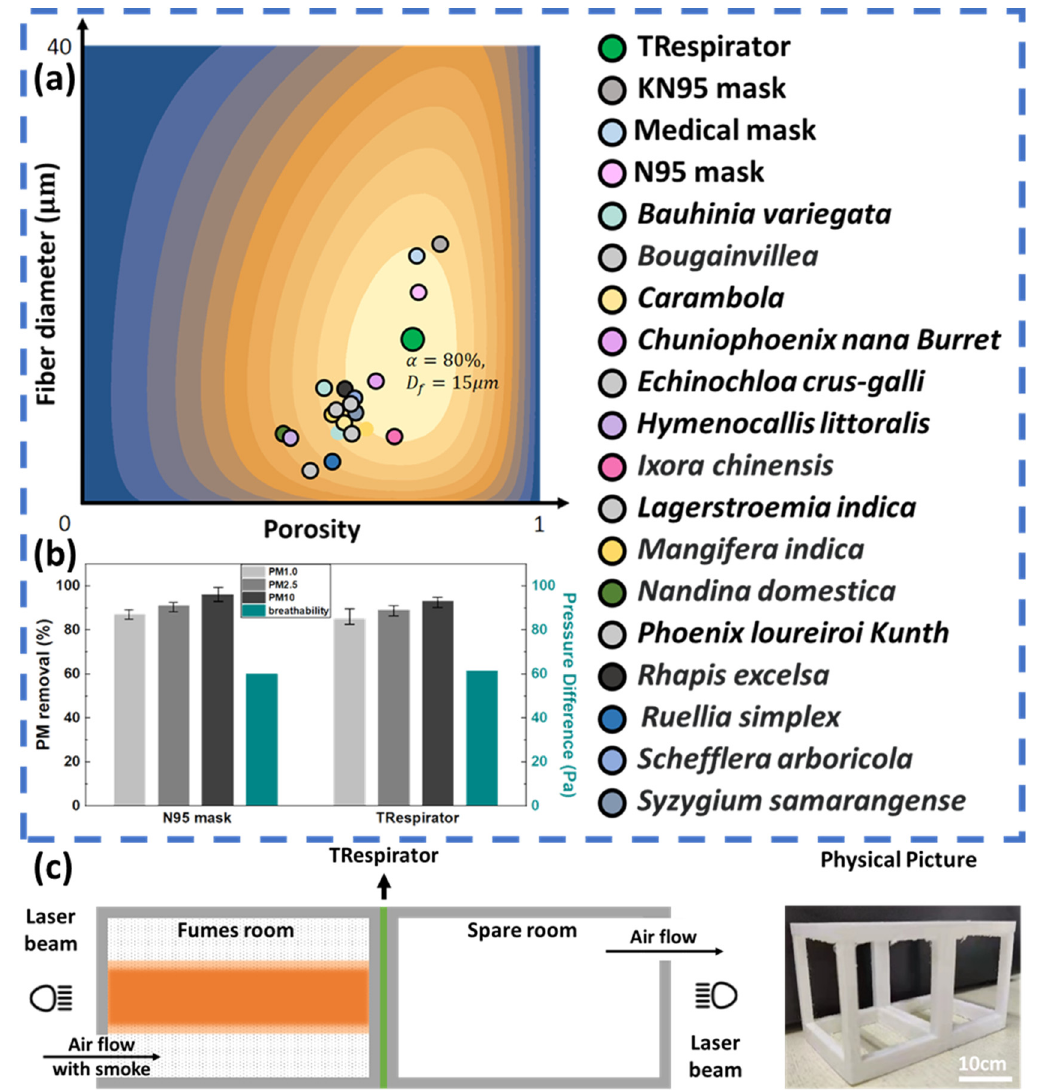
Figure 2. The experimental data about the performance examination of TRespirator ( a ) The heat map of the mask performance index Q, where the gray, light blue, and pink points indicate the corresponding coordinate position of KN95 mask, medical-surgical mask, and N95 mask from up to down, with the green one corresponding to the coordinate of 95% TRespirator, with remaining- colored points matching the other investigating plants listed on the right side. ( b ) PM removal efficiency (PM 1.0 in light grey, PM2.5 in grey, and PM 10 in black) and pressure difference (in blue) of TRespirator compared to those of N95 mask, with the error bar the standard deviation of all testing results, and ( c ) visual smoke adsorption test equipment of TRespirator.